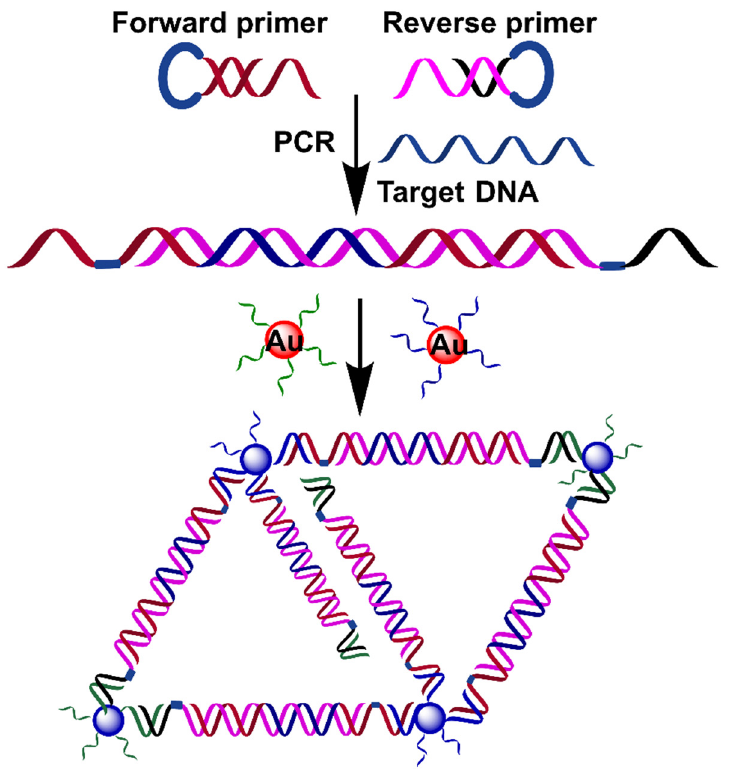
Figure 9. Schematic diagram of PCR dsDNA product with ssDNA-segment-induced assemblies of SNA probes for colorimetric detection of target DNA. Adapted with permission from ref [94]. Copyright 2018 Elsevier.